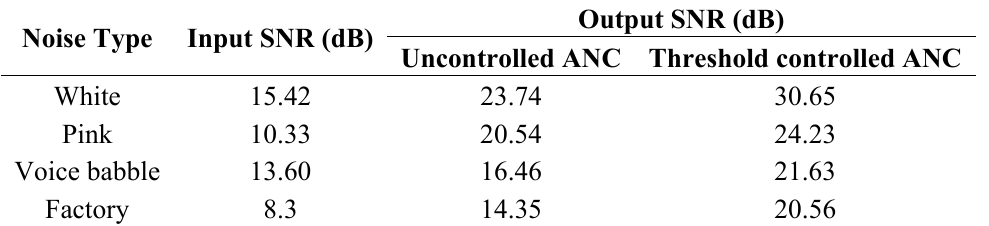
Table 1. Comparison of controlled ANC and uncontrolled noise canceller with various background noise